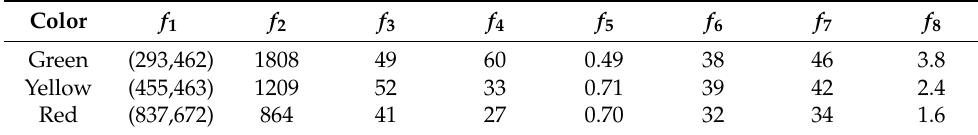
Table 2. Feature vectors of waves in green, yellow, red